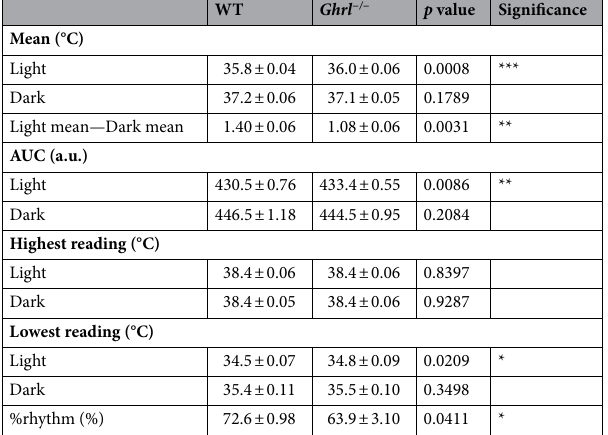
Table 1. The analysis of BT for 10 days in ghrl −/− mice. Light (Light phase), 7:00–19:00; Dark (Dark phase), 19:00–7:00. AUC, area under curve. The asterisks of significance column means. * p < 0.05; ** p < 0.01, and *** p <